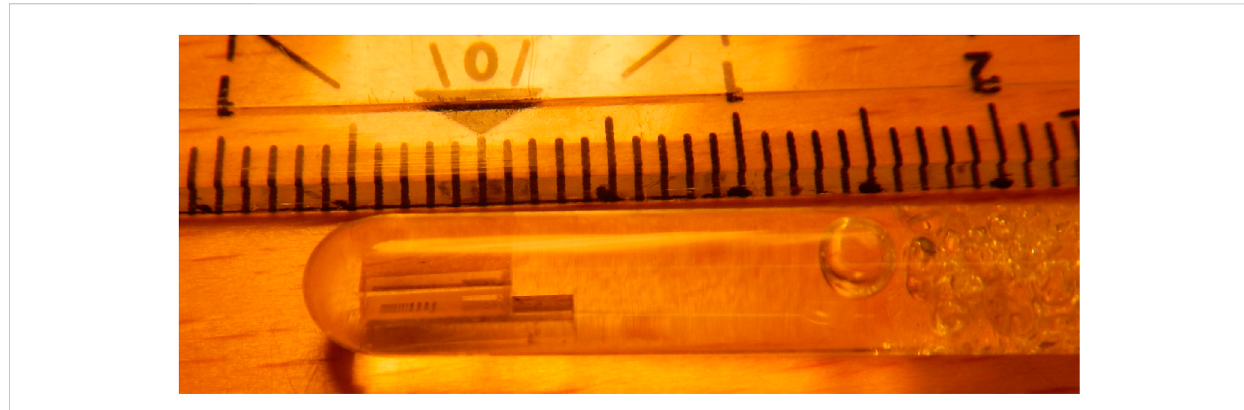
FIGURE 8 Macroscopic photo of the fi nal resolution phantom in a small glass tube (inner diameter di = 4 mm). The PMMA-layer with the two orthogonal grids is embedded in silicon oil, which acts as MR-active fi lling liquid in the slits. The resolution phantom is fi xed in this prototype design using a styrene foam showing air bubbles at right hand side (scale numbers indicating